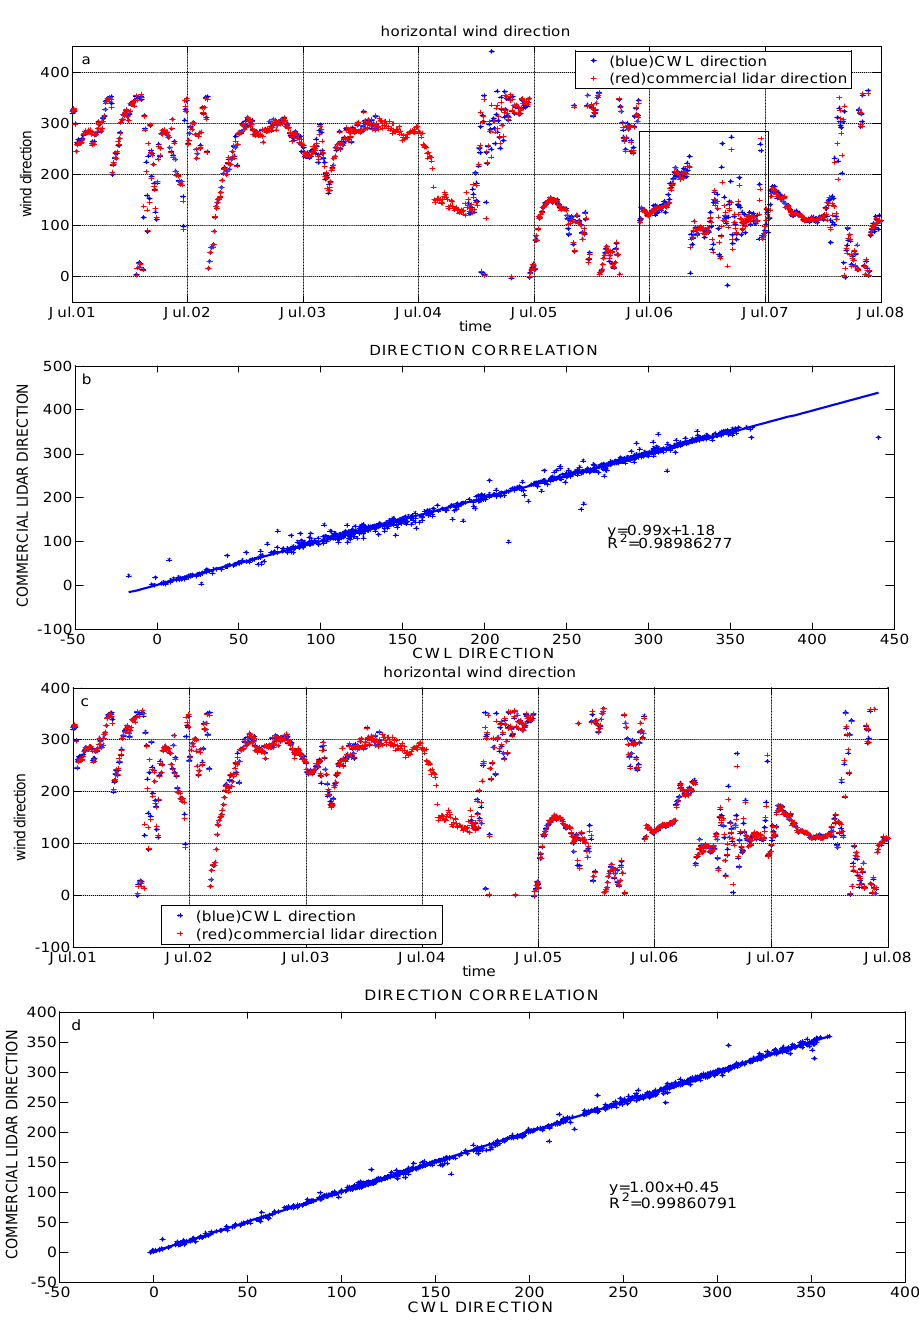
Figure 11. Horizontal wind direction at 120 m: ( a ) horizontal wind direction after COG; ( b ) correlation between the horizontal wind direction after COG and that of the commercial lidar; ( c ) horizontal wind direction after CR-CFAR; and ( d ) correlation between the horizontal wind direction after CR-CFAR and that of the commercial lidar.